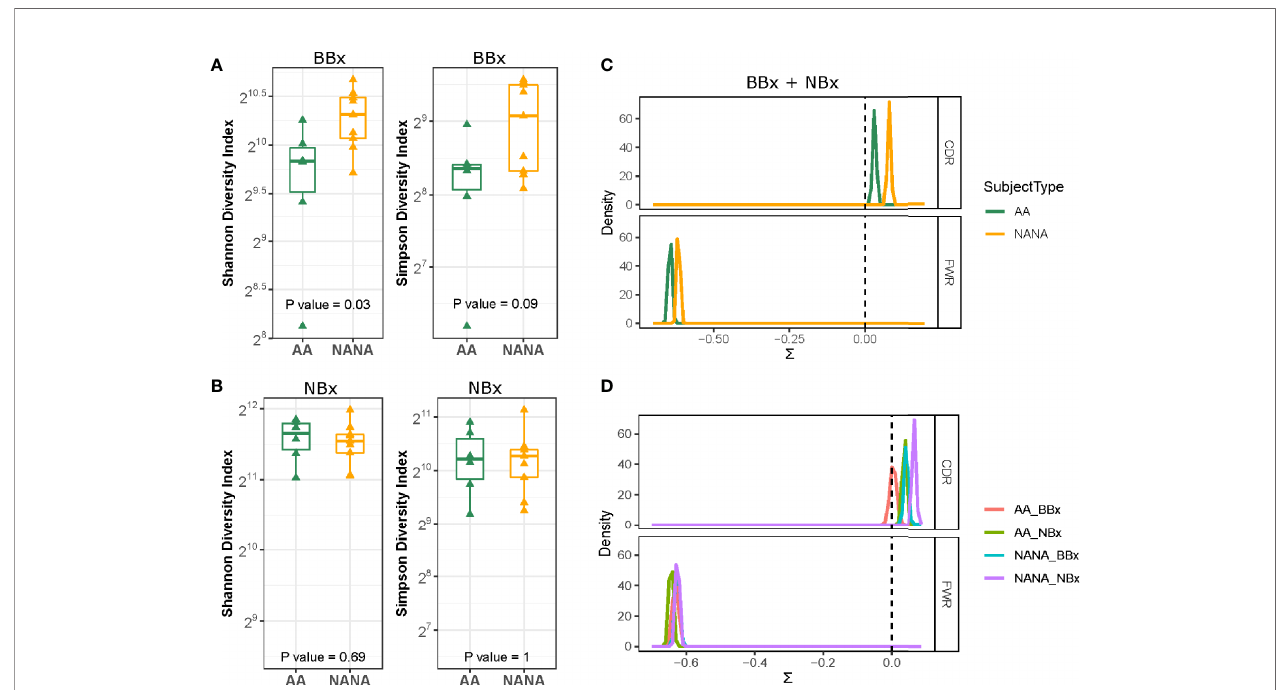
FIGURE 3 | Greater diversity and positive immunoglobulin selection pressure in non-atopic, non-asthmatics (NANA) compared with atopic asthmatics (AA). The Shannon diversity and Simpson diversity indices of immunoglobulin sequences from biopsies from each individual show signi fi cantly less diversity in the asthmatics (green) compared with the non-atopic controls (yellow) in the bronchial (A) but not the nasal biopsies (B) . Comparison of (C) pooled bronchial and nasal biopsy immunoglobulin sequences from asthmatics and non-atopic control samples (green and yellow, respectively) and (D) bronchial (red) and nasal (green) biopsy sequences from the atopic asthmatics and bronchial (blue) and nasal (purple) sequences from the non-atopic controls shows a higher degree of antigen-driven selection in the complementarity determining regions (CDRs) of the antibodies in the non-atopic controls compared with the atopic asthmatics. Statistically signi fi cant differences between the subject groups were found in the framework regions (FWR) when bronchial and nasal biopsy samples were combined (C) but not for individual sample types (D)